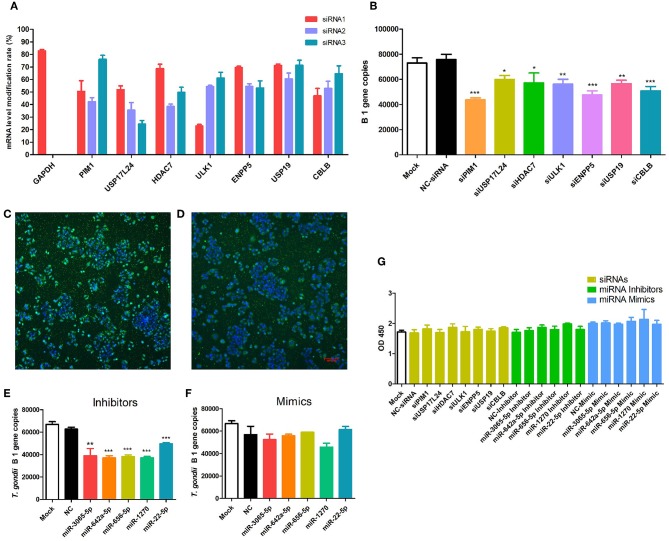
Validation of seven selected T. gondii host dependency factors (HDFs). (A) Among the HDFs, seven genes (CBLB, USP17L24, USP19, HDAC7, ULK1, PIM1, and ENPP5) were selected for siRNA gene knockdown assay on Hela cells. Three siRNAs were designed for each gene, and siRNAs with the highest knockdown efficiency were chosen for the further experiments. (B) When specific genes were knocked down with selected siRNA for 24 h, T. gondii was used to infect cells at MOI = 1 for 36 h. Proliferation of T. gondii was significantly inhibited in siRNA treated groups compared with mock and negative control siRNA treated groups. (C,D) FAM-tagged control miRNA inhibitor and mimic transfected Hela cells showed the transfection rate. (E,F) Compared with mock and negative control siRNA treated groups, multiplication of T. gondii was significantly suppressed in specific miRNA inhibitor treated group, but not significantly changed in mimic treated group. (G) Viability of Hela cells in siRNA, inhibitor, and mimic treated groups was not significantly changed. * p < 0.05, ** p < 0.01, *** p < 0.005.